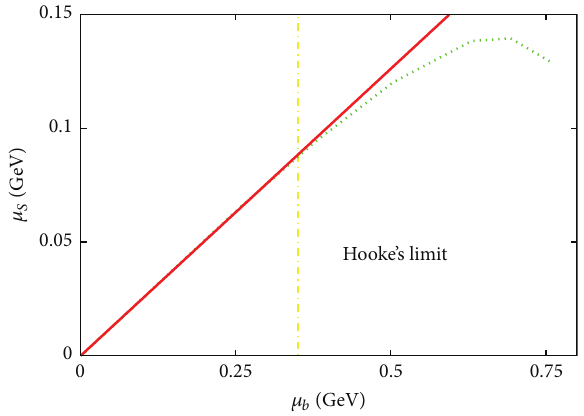
Figure 16: 𝜇 𝑆 as a function of 𝜇 𝑏 in hadron resonance gas model (dotted curve). The linear fitting is given by solid